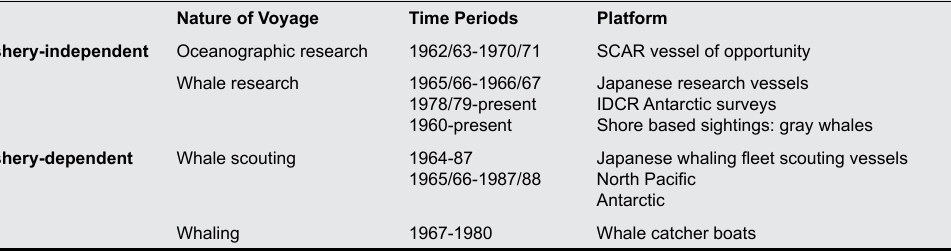
Table 1. Fishery-dependent and fishery-independent forms of sighting data collected beginning in the mid 1960s within the IWC Scientific Committee classified by the nature of the voyage, the time period when the data were collected, and the nature of the